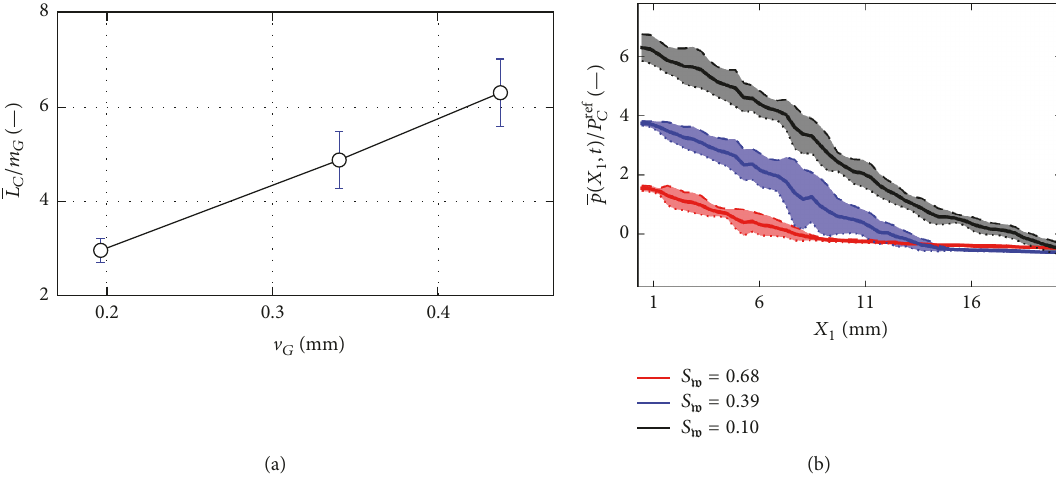
Figure 6: (a) Normalized average width 𝐿 𝐶 of CDZ during stable displacement as a function of standard deviation V 𝐺 of grain diameter distribution. Blue error bars correspond to standard deviations of 𝐿 𝐶 (𝑡) . (b) Normalized pressure profiles in flow direction for microstructure Catlog 10 ( Ca ,𝑀) = (−2,1) .Solidlinesrepresentaveragefluidpressureprofiles 𝑝(𝑋 1 , 𝑡) withinverticalaveragingslicesofwidth Δ𝑋 1 = 𝐿 𝑊 /50 . Dotted and dashed lines correspond to lower and upper bounds to fluid pressure distribution and envelop 87% of pressure data (shaded